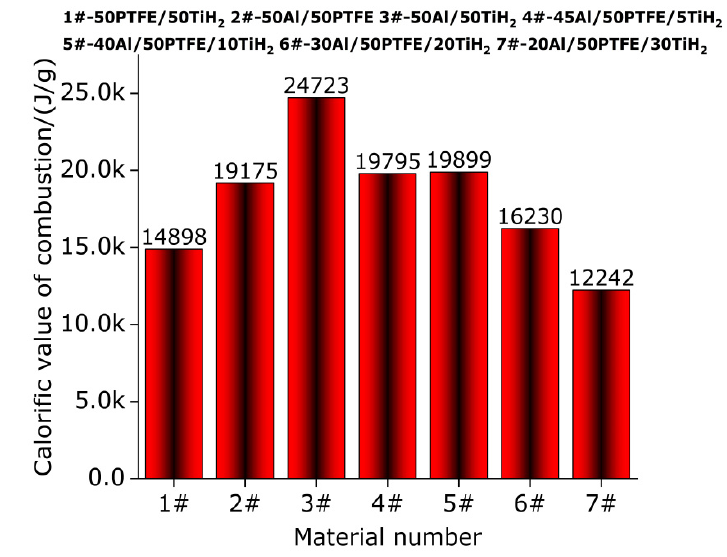
Figure 22. Calorific value of oxygen bomb combustion of active materials.